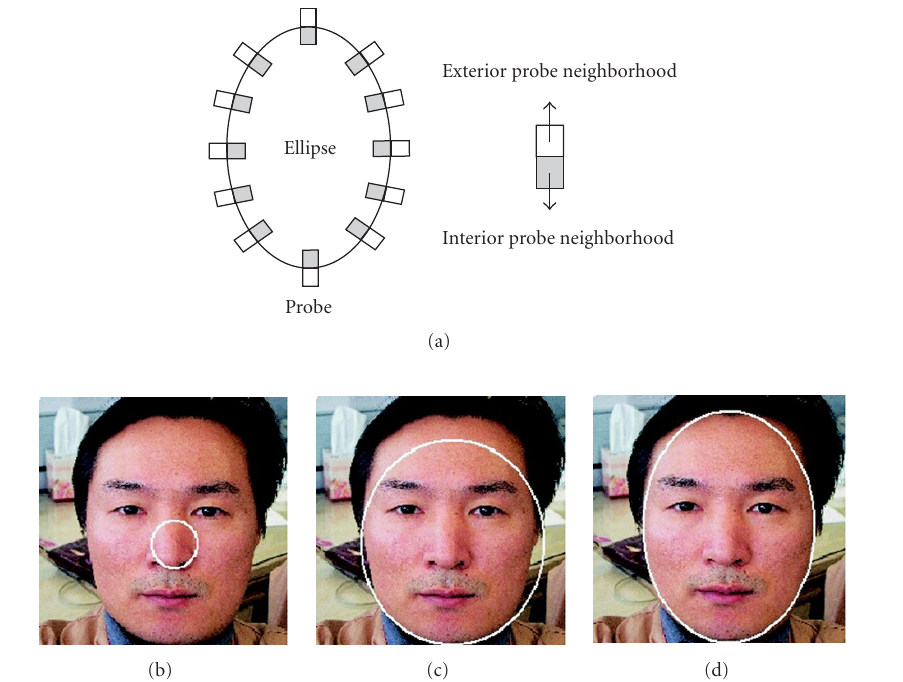
Figure 3: Face region detection with deformable model. (a) Deformable model. (b), (c), and (d) Convergence of the deformable model.